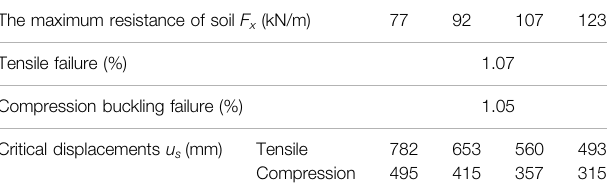
TABLE 3 | The results of critical displacements of the thawing landslide of the soil under an ultimate strain. The maximum resistance of soil F x (kN/m)